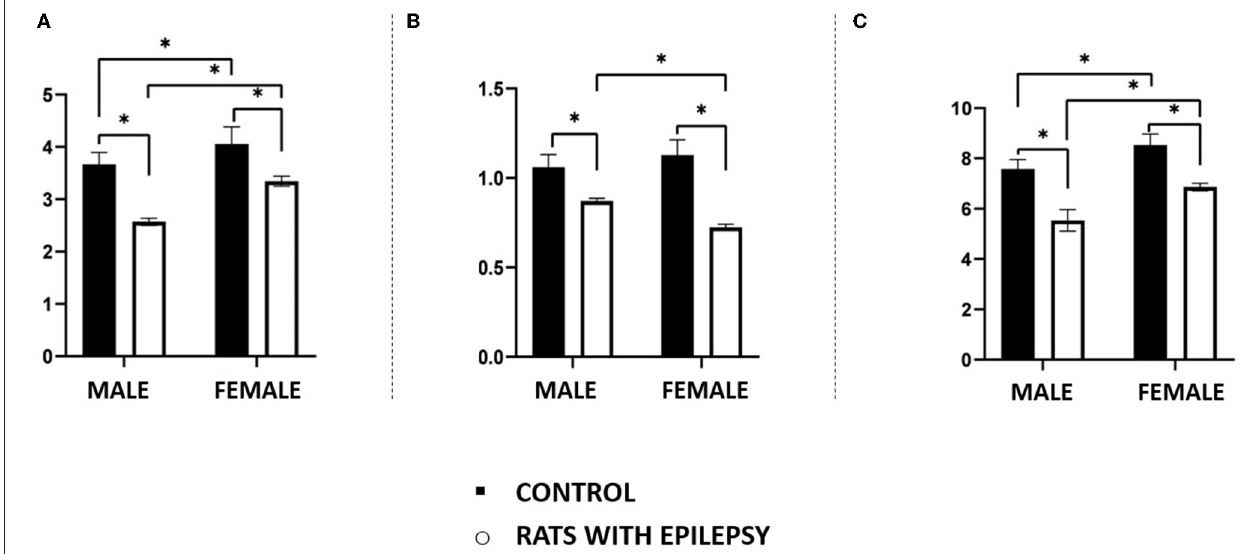
FIGURE 4 | Number (in millions) of neurons in the hippocampus (A) , amygdala (B) , and olfactory bulb (C) of male and female rats submitted to the pilocarpine model of epilepsy compared to that observed in respective controls. Data are expressed as mean ± SD. Data from rats with epilepsy were compared with those of their respective controls using two-way ANOVA followed by Tukey’s post-hoc test. * p < 0.05.